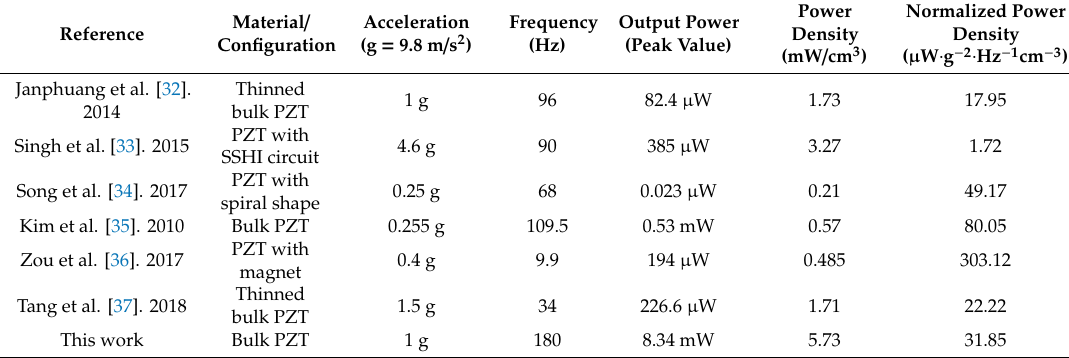
Figure 6. Energy harvesting curve of the 25-mm ( a ), 22-mm ( b ), 19-mm ( c ) hole-digging PCD energy harvesters, and ( d ) their output power comparison diagram. Table 2. The performance comparison of the PCD energy harvester with other published